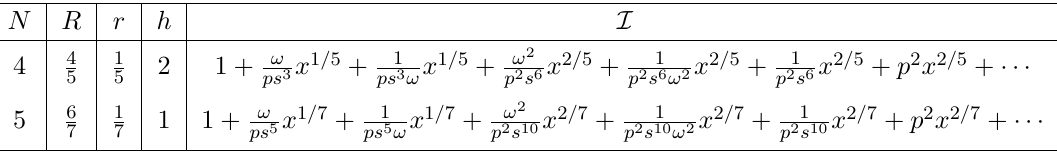
(cid:0) (cid:1) x h .